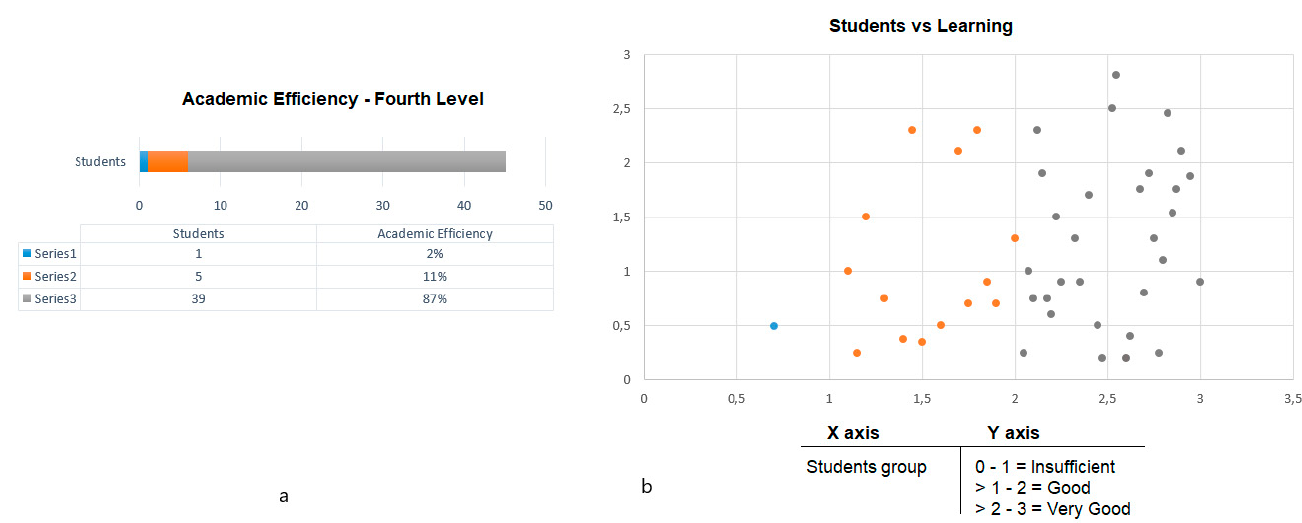
Figure 10. Evaluation of academic effectiveness vs. the learning of fourth-level students in the current education model (classes through synchronous meetings).